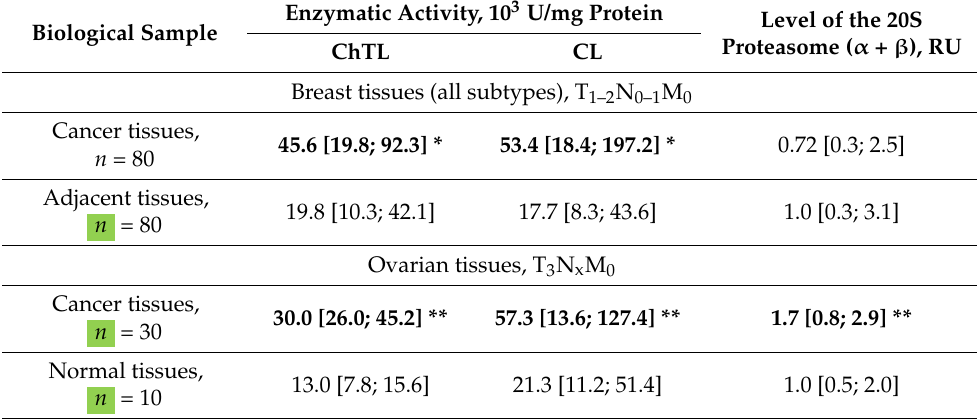
Table 1. Proteasomal activity and the level of 20S proteasome in breast and ovarian cancer tissues. Biological Sample